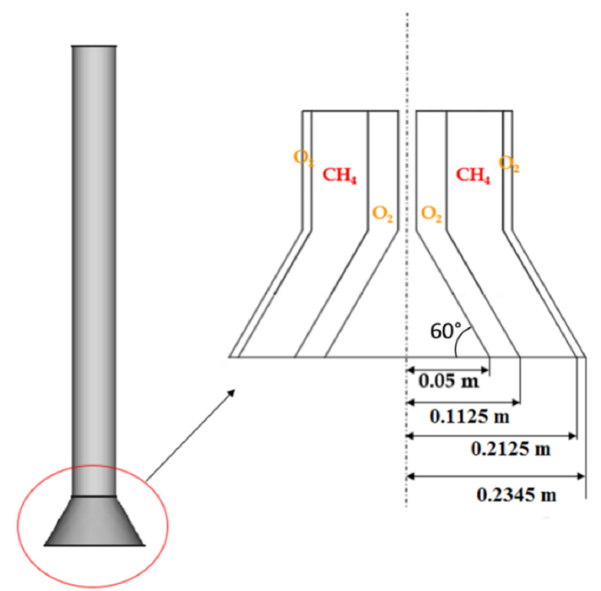
Figure 9. Burner configuration.